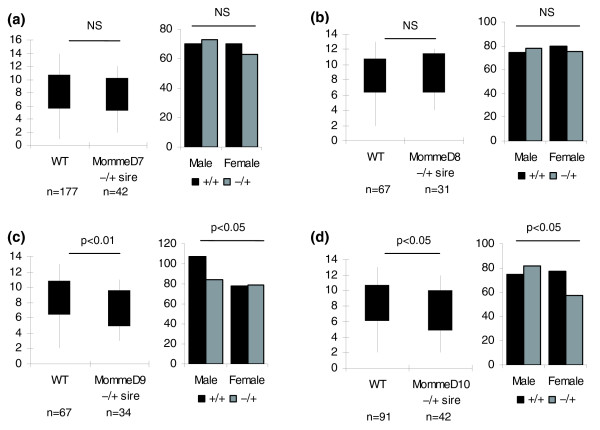
Genotypes and sex of offspring, and litter size following paternal transmission of MommeD7-D10. (a) MommeD7, (b) MommeD8, (c) MommeD9, and (d) MommeD10 show the numbers of male and female offspring of wild-type (WT; black) and heterozygous (grey) genotype produced following a cross between a male heterozygous Momme and a wild-type female. MommeD9 and MommeD10 both show a trend towards transmission ratio distortion and a significant reduction in litter size compared to wild-type crosses. n represents the number of litters produced.